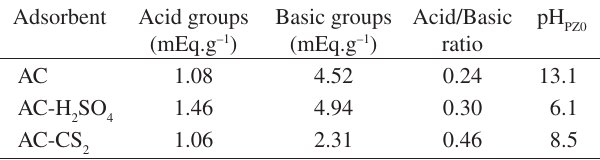
experimental results. PZC